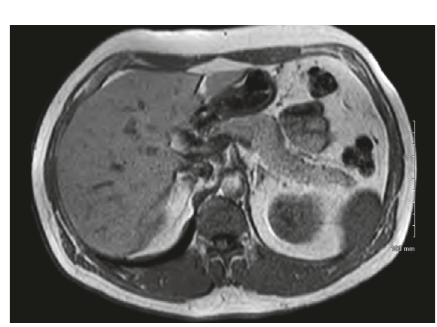
Figure 4: Follow-up imaging at 5 months showing resolution with no discrete pancreatic head